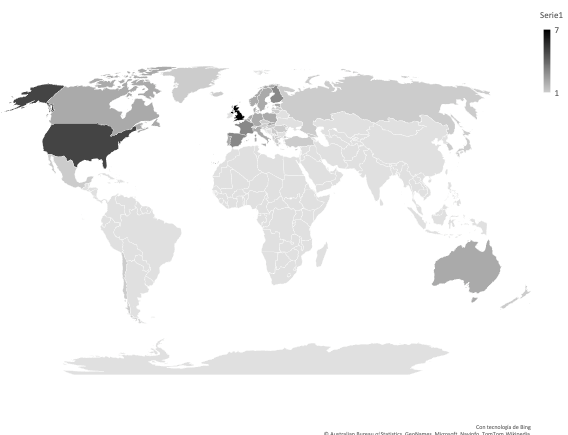
Figure 3. Articles published per